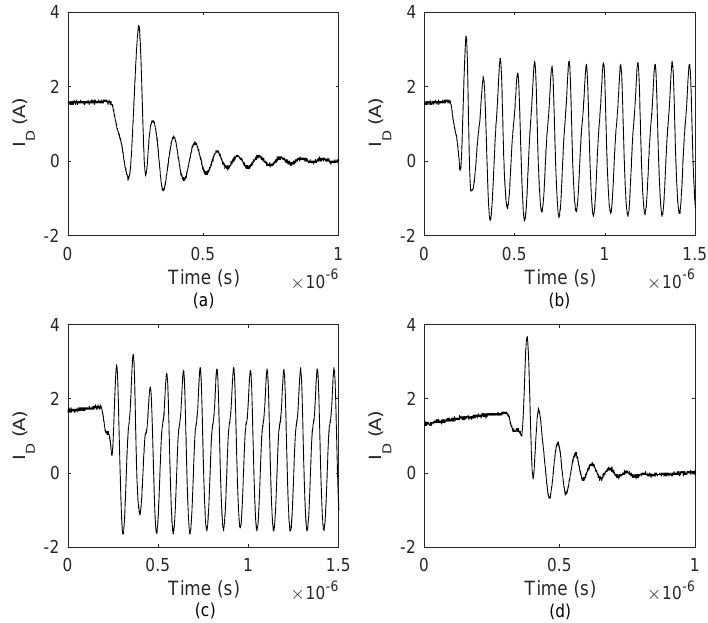
Figure 21. The experimental type II oscillation waveforms of the drain current I D with R G = 1.5 Ω . ( a ) L G = 41 nH and V DC = 100 V. ( b ) L G = 22 nH and V DC = 100 V, ( c ) L G = 22 nH and V DC = 200 V, ( d ) L G = 22 nH and V DC = 300 V. Table 7. A comparison between the ζ 2 and number of oscillation cycles N C ( bold ) with various L G and R G with L C = 460 nH. L G 22 R G